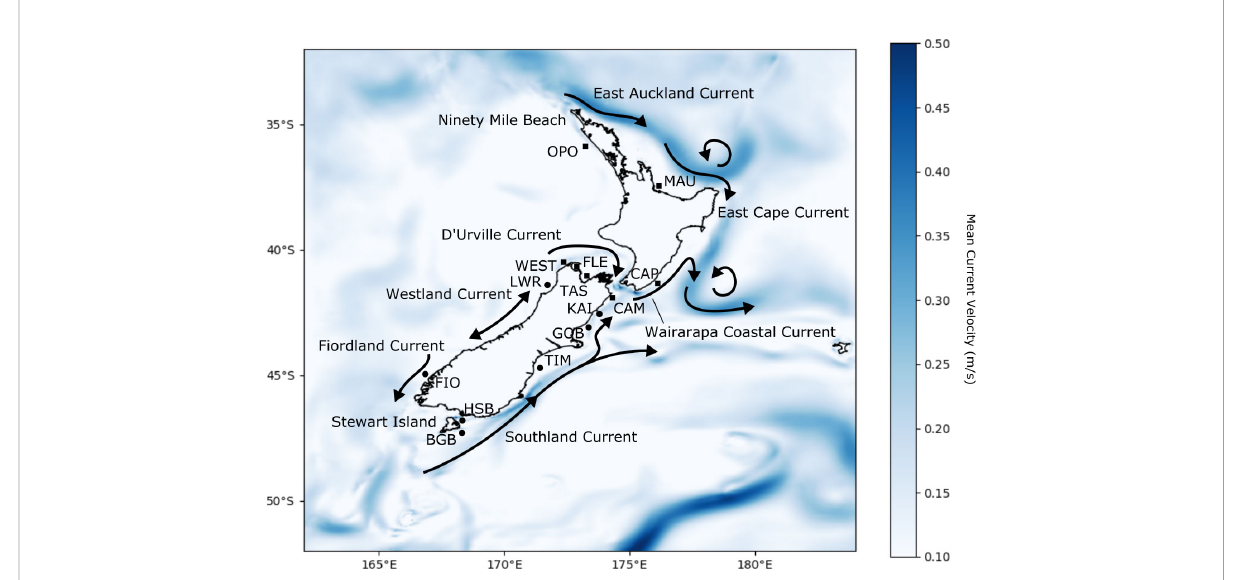
FIGURE 1 Map of sites sampled by Apte and Gardner (2002) and Wei et al. (2013) used for this study: Opononi (OPO, n = 27), Maunganui (MAU, n = 29), Castlepoint (CAP, n = 30), Westhaven (WEST, n = 13), Fletchers Beach (FLE, n = 14), Tasman Bay (TAS, n = 20, one individual missing data at one locus), Cape Campbell (CAM, n = 30, one individual missing data at one locus), Little Wanganui River (LWR, n = 26), Kaikoura (KAI, n = 16), Gore Bay (GOB, n = 28), Timaru (TIM, n = 22, one individual missing data at one locus), Fiordland (FIO, n = 19), Horseshoe Bay (HSB, n = 22), and Big Glory Bay (BGB, n = 20). Populations are coded according to genetic clusters reported by Wei et al.: squares represent populations in the northern cluster and circles represent populations in the southern cluster. Landmarks referenced in the text and prevailing currents around New Zealand are shown. Mean current velocity magnitudes across the 23 years of the analysis are represented by the blue fi